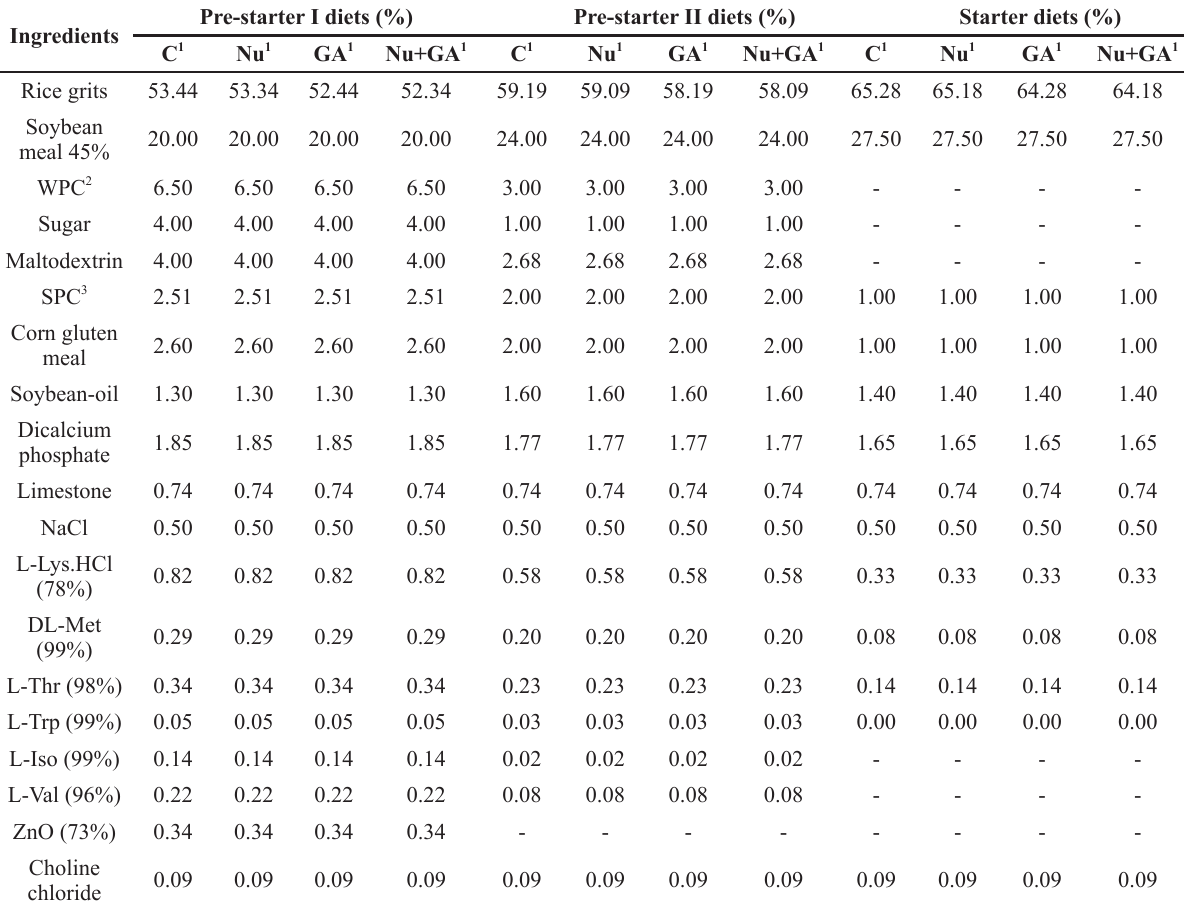
Percentual composition and calculated nutritional values of experimental